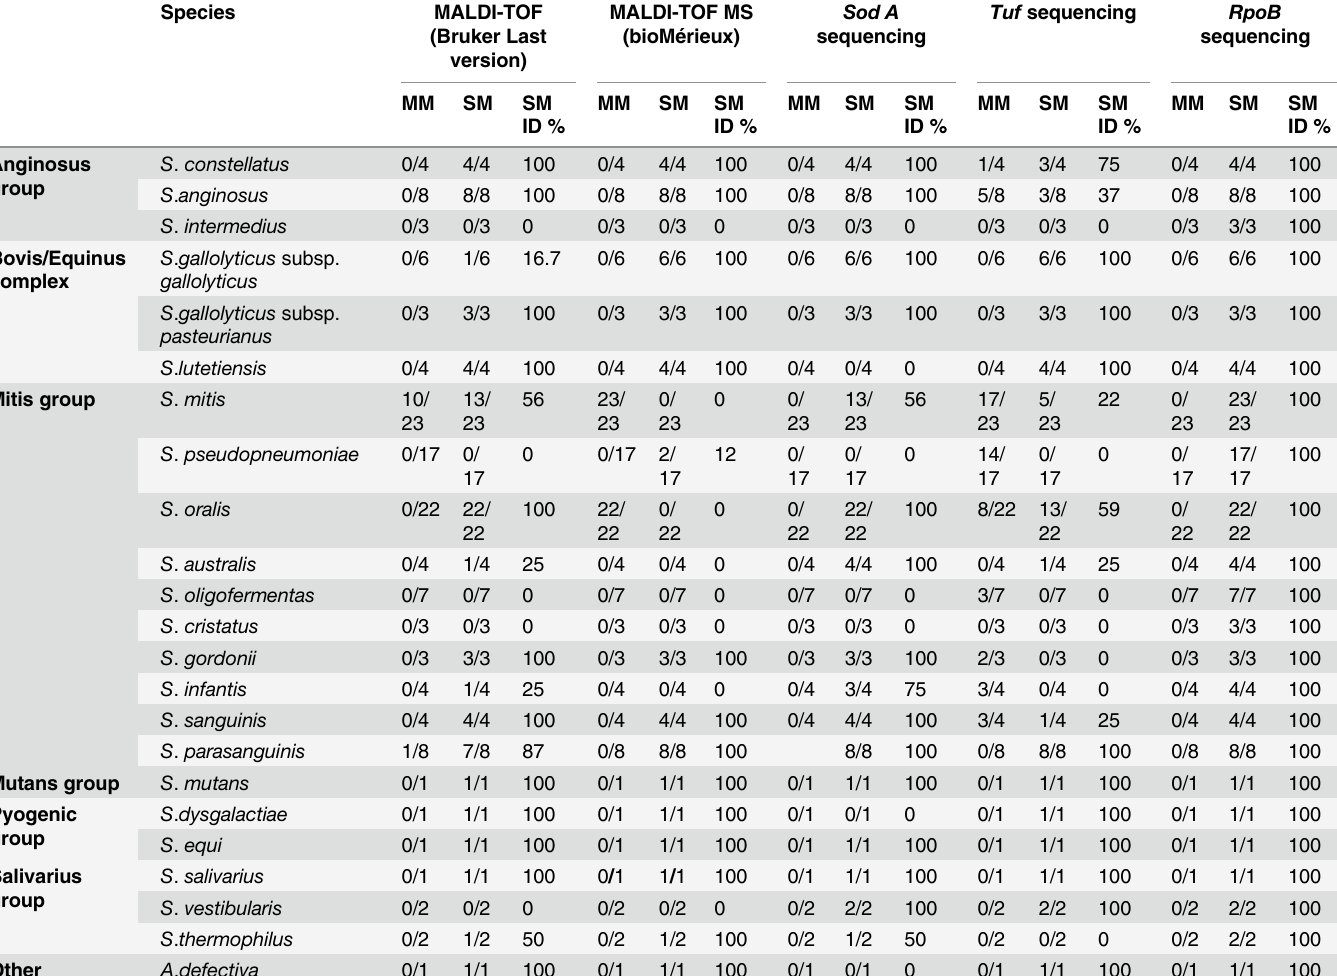
Table 4. MALDI-TOF, sodA and tuf identi fi cation performance versus rpoB genes sequencing: ability to identify non pneumococcal VGS as single match (SM) or multiple match (MM).